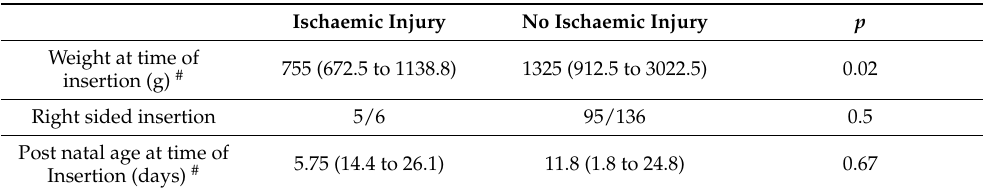
Table 6. Weight at time of insertion, post natal age and side of insertion in babies with and without ischaemic injury following FAC